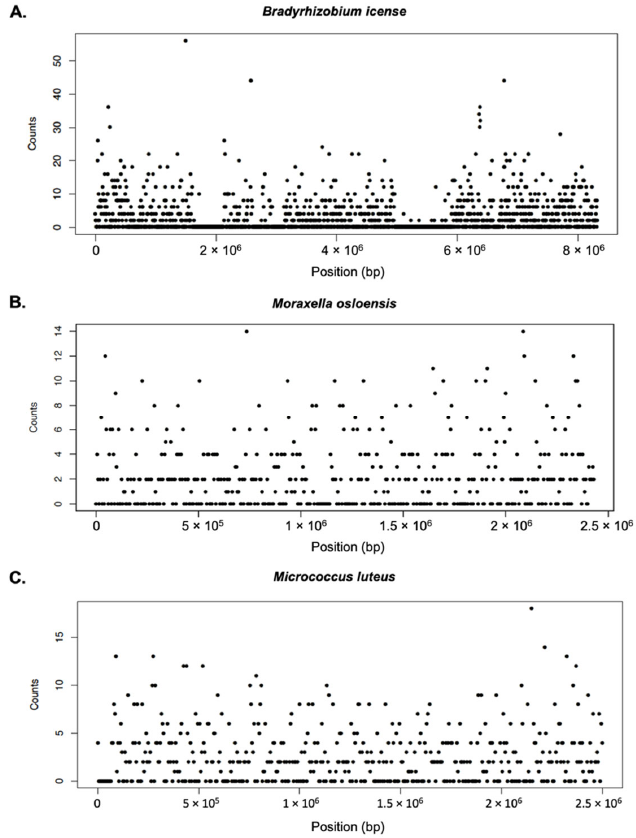
Figure 2. Genomic sequencing coverage. ( A ) Bradyrhizobium icense , ( B ) Moraxella osloenosis , and ( C ) Micrococcus luteus . Each window is shown by a dot and each dot represents sequence reads of 100 bp size.